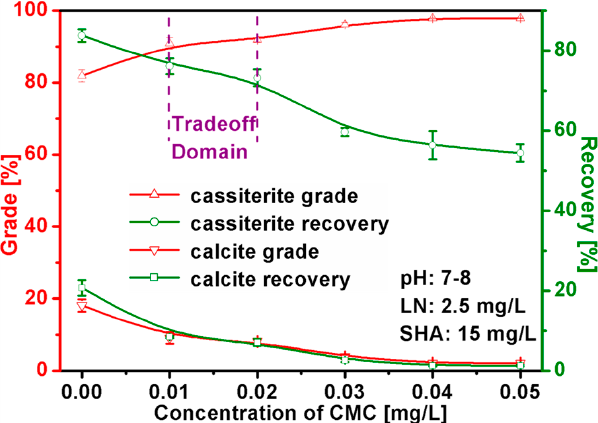
Figure 4. Grade and recovery of cassiterite in mixed binary minerals as a function of CMC concentration.